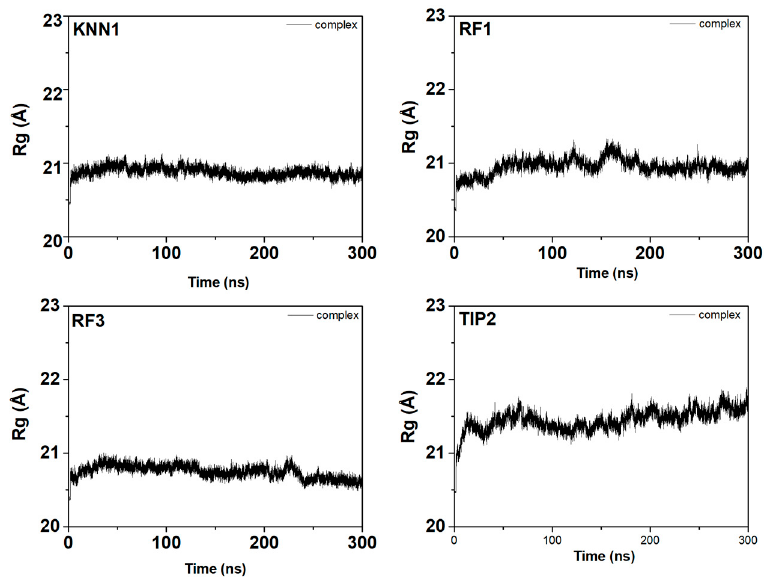
Figure 8. Radius of gyrus plots of the tyrosinase-hdTIPs complexes during 300 ns of the molecular dynamic simulation time.